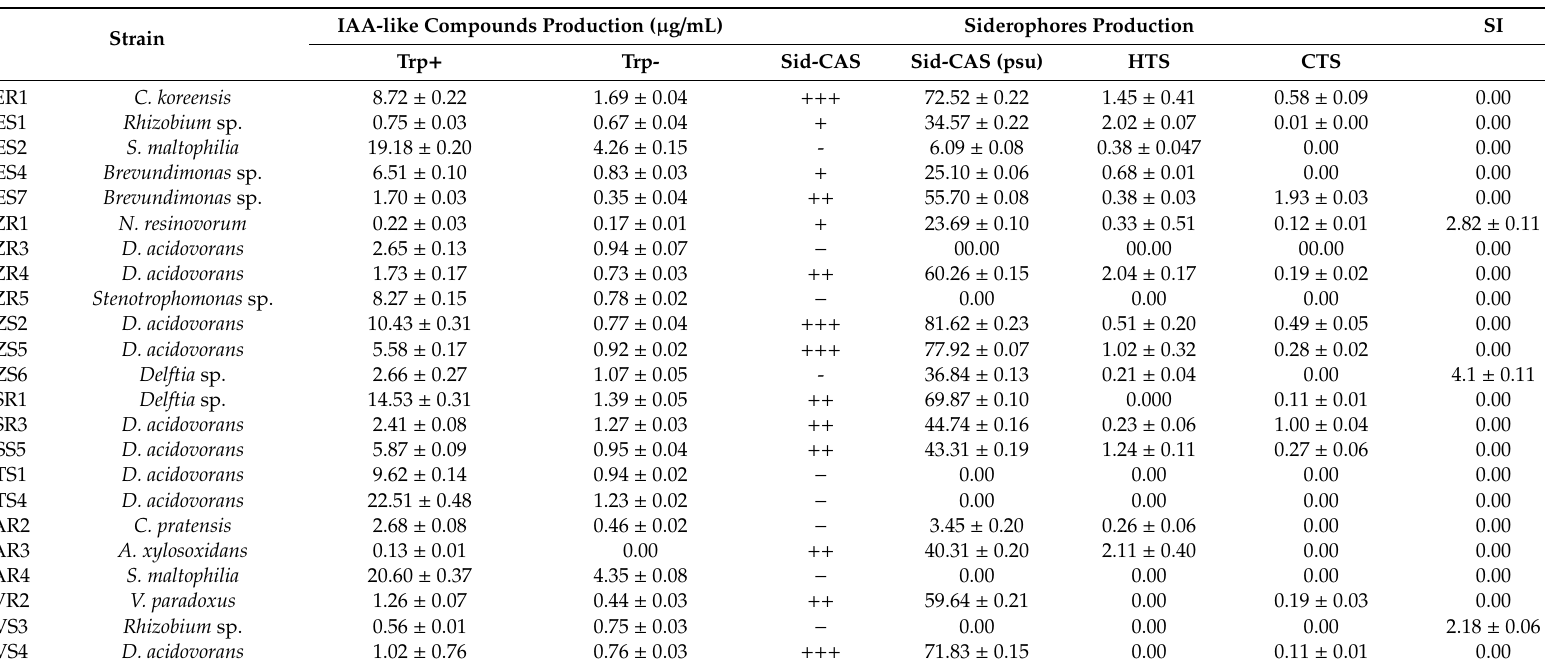
Table 2. Features associated with potential plant growth promoting (PGP) activities of bacterial isolates: indole-3-acetic acid (IAA)-like compounds production, siderophores production and phosphate solubilization. The values are means ± standard deviation (SD; n =